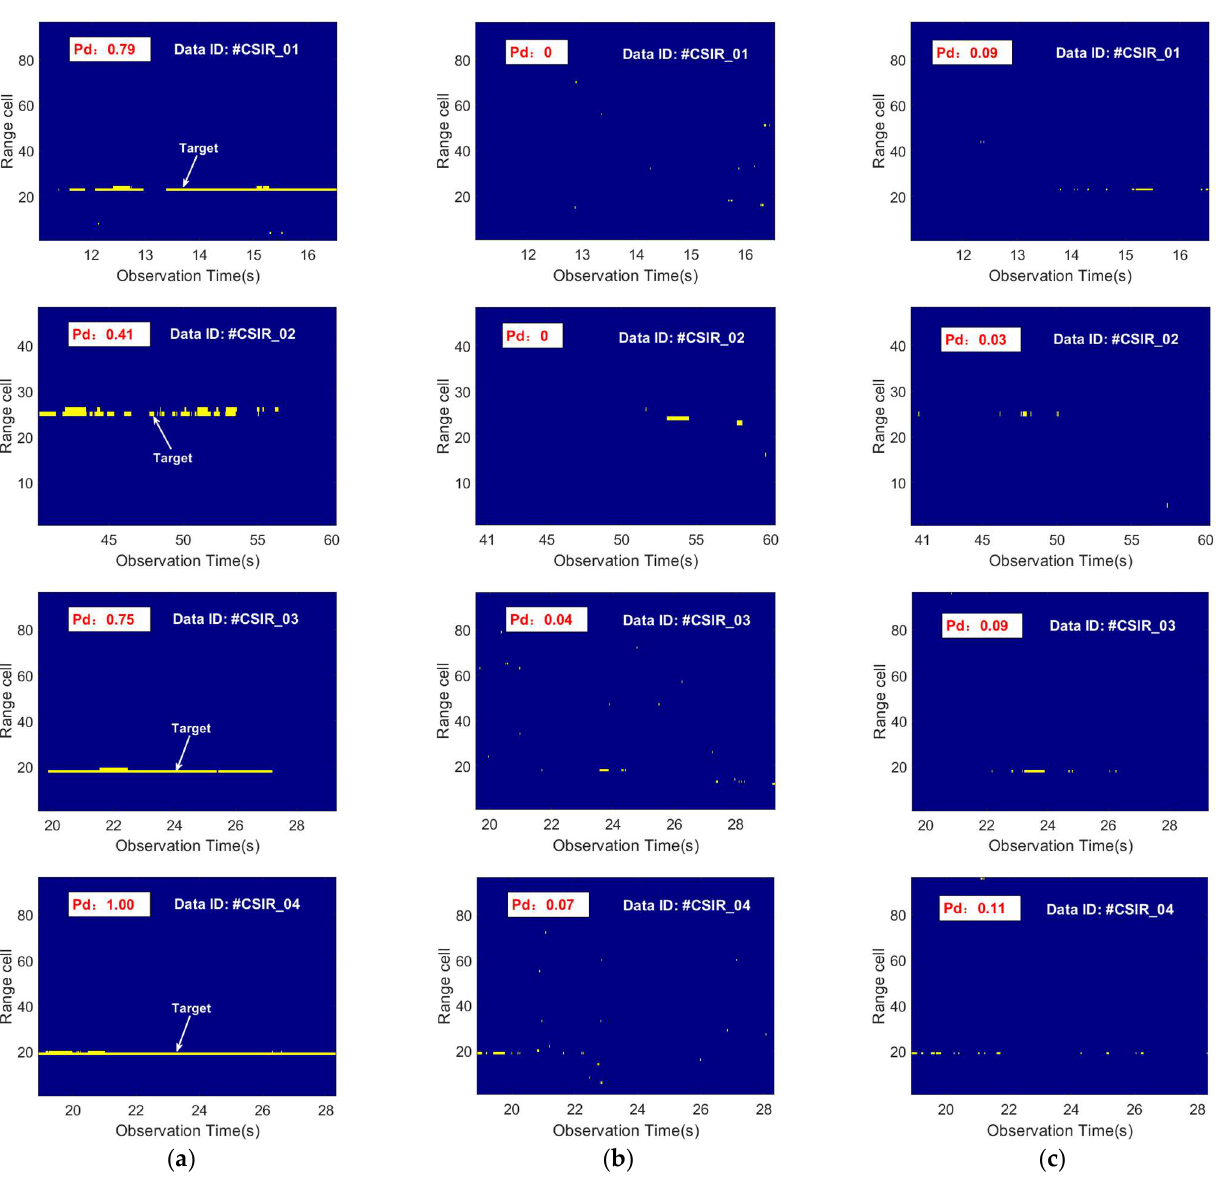
Figure 12. The detection results of different detection methods on different marine floating target data are visualized. The detection result is obtained from the test samples. The radar observation time is 0.512 s and the false alarm probability is 10 − 3 . The radar observation targets of the data in the first and second rows are floating fishing boats and the data in the third and fourth rows are floating RIB. The arrow points to the correct target location for detection. The yellow marker is the detected target location. ( a ) Proposed detector; ( b ) Feature-based detector using three TF features [17]; and ( c ) Tri-feature-based detector